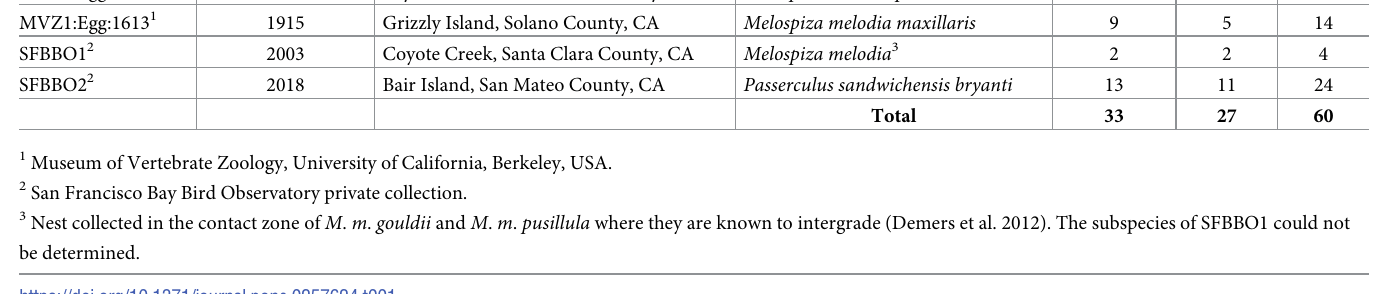
the structure and lining, of the nest. Initial sampling in the contemporary nest specimens SFBBO1 and SFBBO2 was less systematic and intensive as these specimens were used to test the approach before sampling historical nests, however the materials selected were representa- tive of the materials in the structure and lining of each specimen. Each sample constituted a single contiguous piece of plant material from the nest. All samples were photographed and weighed before DNA was extracted (S1 and S2 Figs, S1 Table). Care was taken to prevent cross-contamination between samples by using instruments initially sterilized with 70% EtOH, cleaning instruments between sampling with sterile delicate task tissue, using different